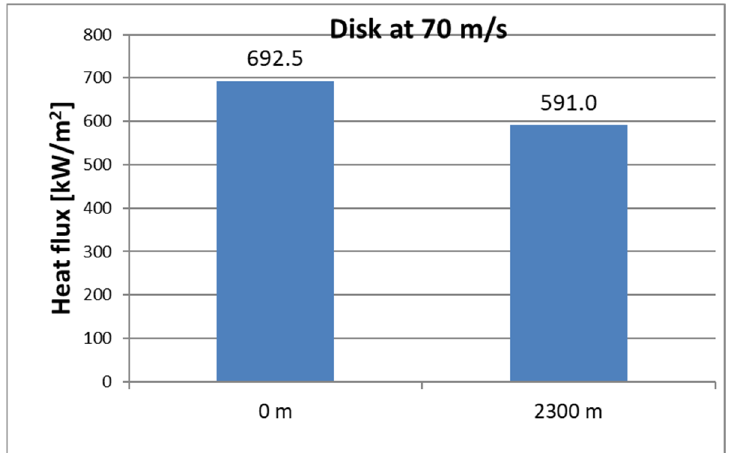
Figure 21. Comparison of heat dissipation values from the disk at different altitudes—coupled heat transfer case at 70 m/s.